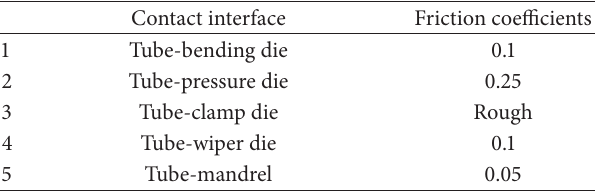
Table 2: Friction coefficients in various contact